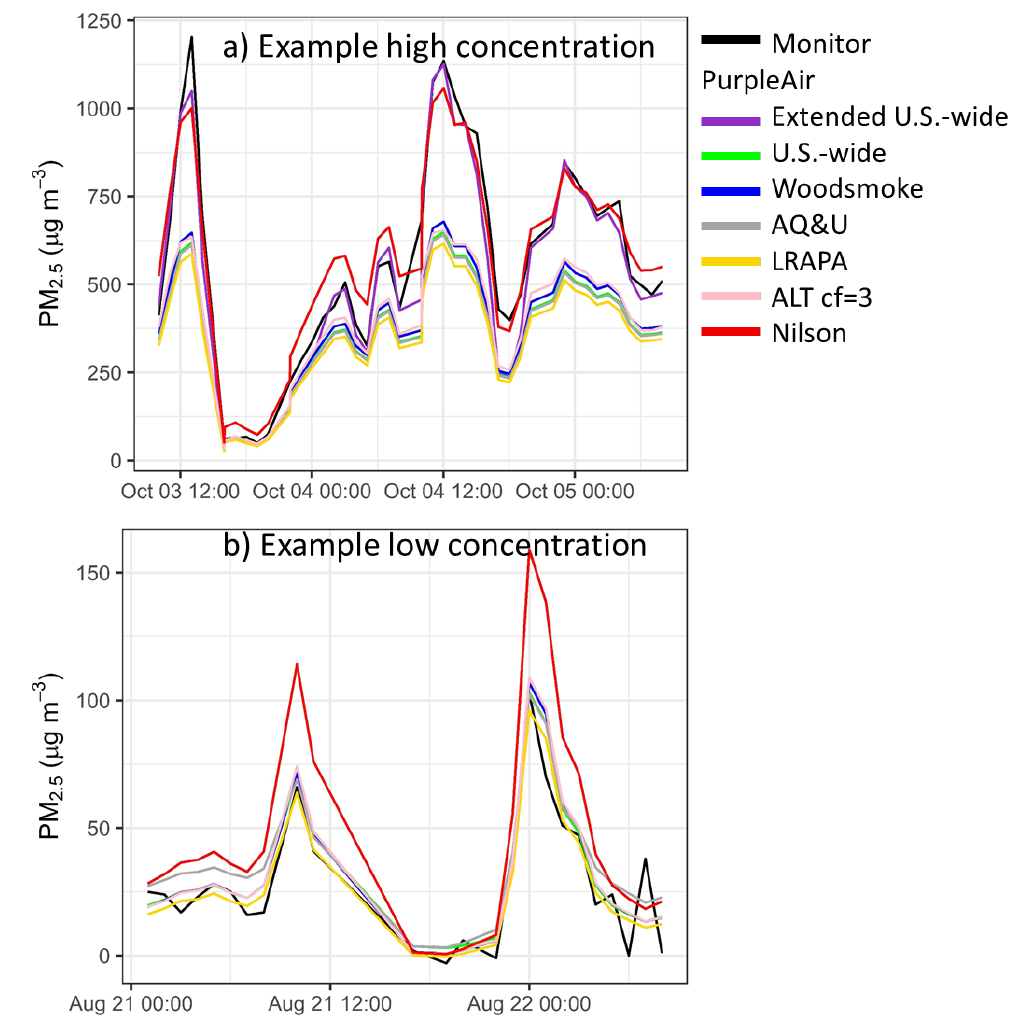
Figure 4. Example time series from the Forks of Salmon, CA showing the data that were corrected, based on different corrections on the PurpleAir map (Woodsmoke, AQandU, LRAPA, ALT cf = 3) and in the literature (Nilson).